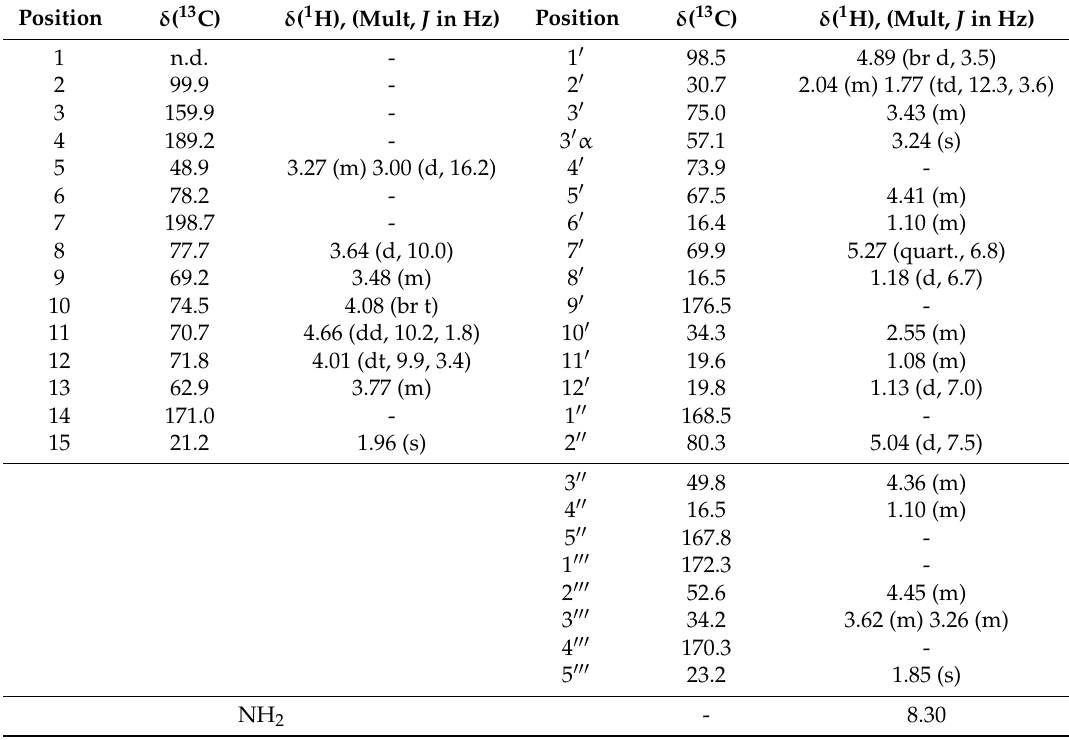
Table 1. NMR data ( δ in ppm) for compound 1 (DMSO- d 6 , 500 MHz, 24 ◦ C). Carbon chemical shifts derived from HSQC and HMBC